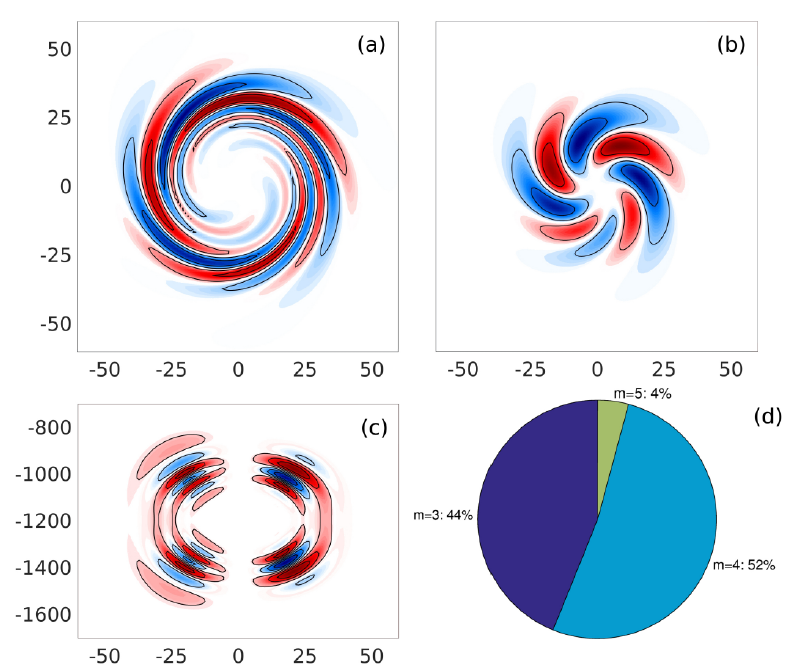
Figure 4. Optimal perturbation for the time interval τ = 17 days. ( a ) PVA horizontal section through the vortex core. ( b ) PVA section through the vortex lobes. ( c ) PVA vertical section. ( d ) Energy distribution on the azimuthal modes.